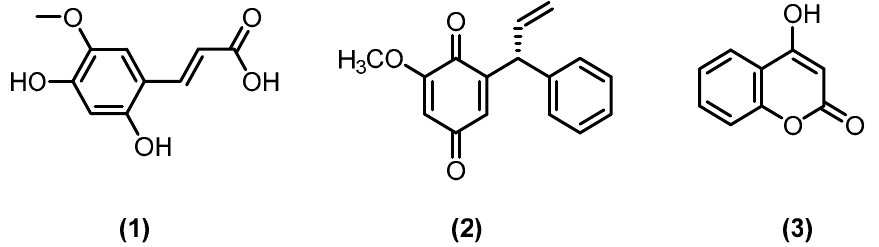
Figure 2. Isolated bioactive constituents of V. betonicifolia : 2,4-dihydroxy, 5-methoxy-cinnamic acid ( 1 ), 3-methoxydalbergione ( 2 ), and 4-hydroxy coumarin ( 3 ).